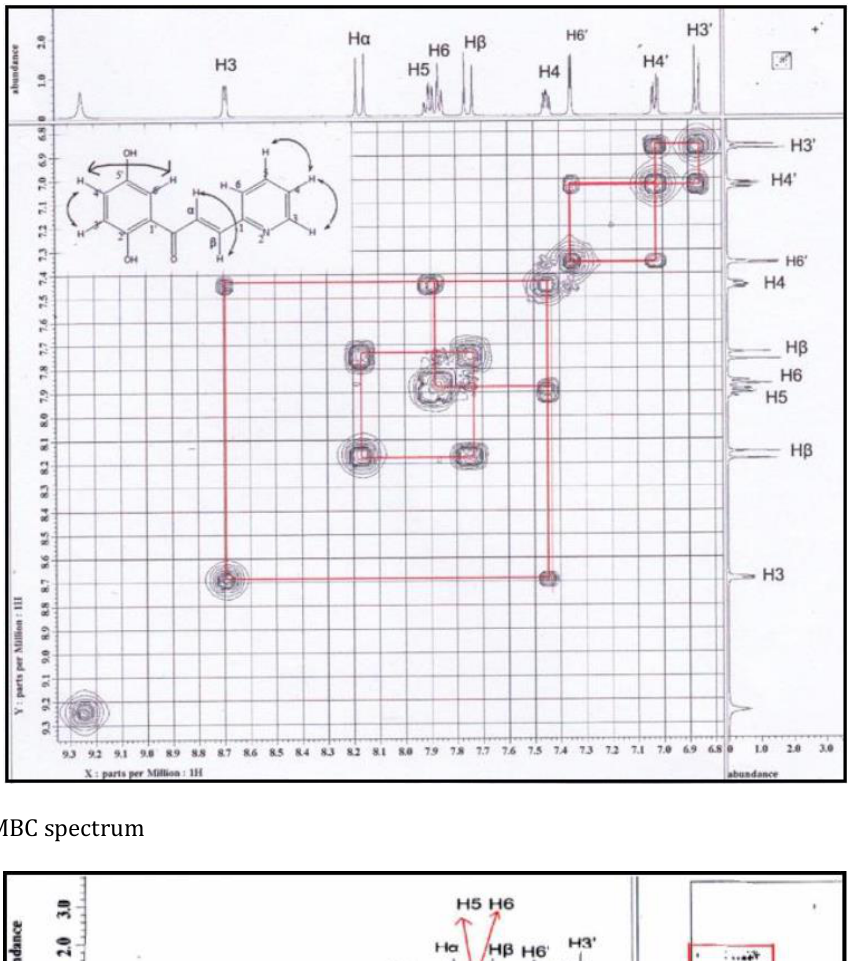
Figure 11. HMBC spectrum